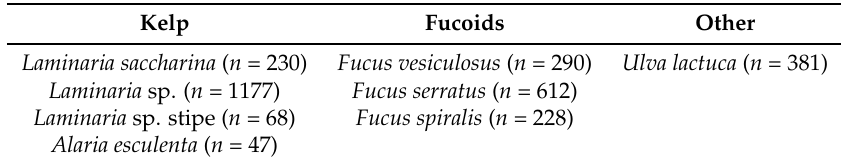
Table 1. Groups of investigated species causing similar functional damage, the number of readings ( n ) are displayed in brackets next to each corresponding species.